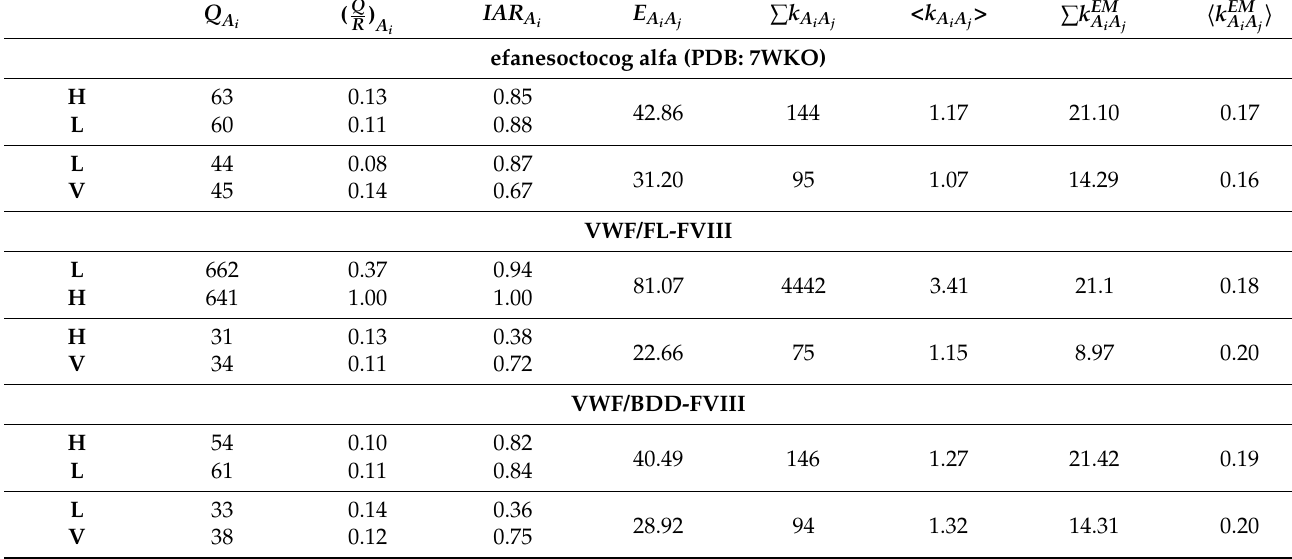
Table 6. Topological descriptors for the complex interfaces. Q is the total number of residues for each chain in the interface. R is the length of the chain involved in the interface. Q/R is the interface “roughness.” IAR = R/N is the interface amino acid range, where N is the total number of residues in the chain. E A is the graph energy of the interface. ∑ k A is the inter-chain degree. < k A > is the i A j i A j i A j average value of the inter-chain degree. ∑ k EM A is the energy of interface interaction, computed as i A j the sum of all contributions for all contacts between chain A i and A j . < k EM A > is the average value of i A j the interaction energy. H is the label for heavy chain of FVIII, L is the label for light chain of FVIII, and V is the label for VWF. In the VWF/FL-FVIII complex, the VWF interacts with B domain in the heavy chain of